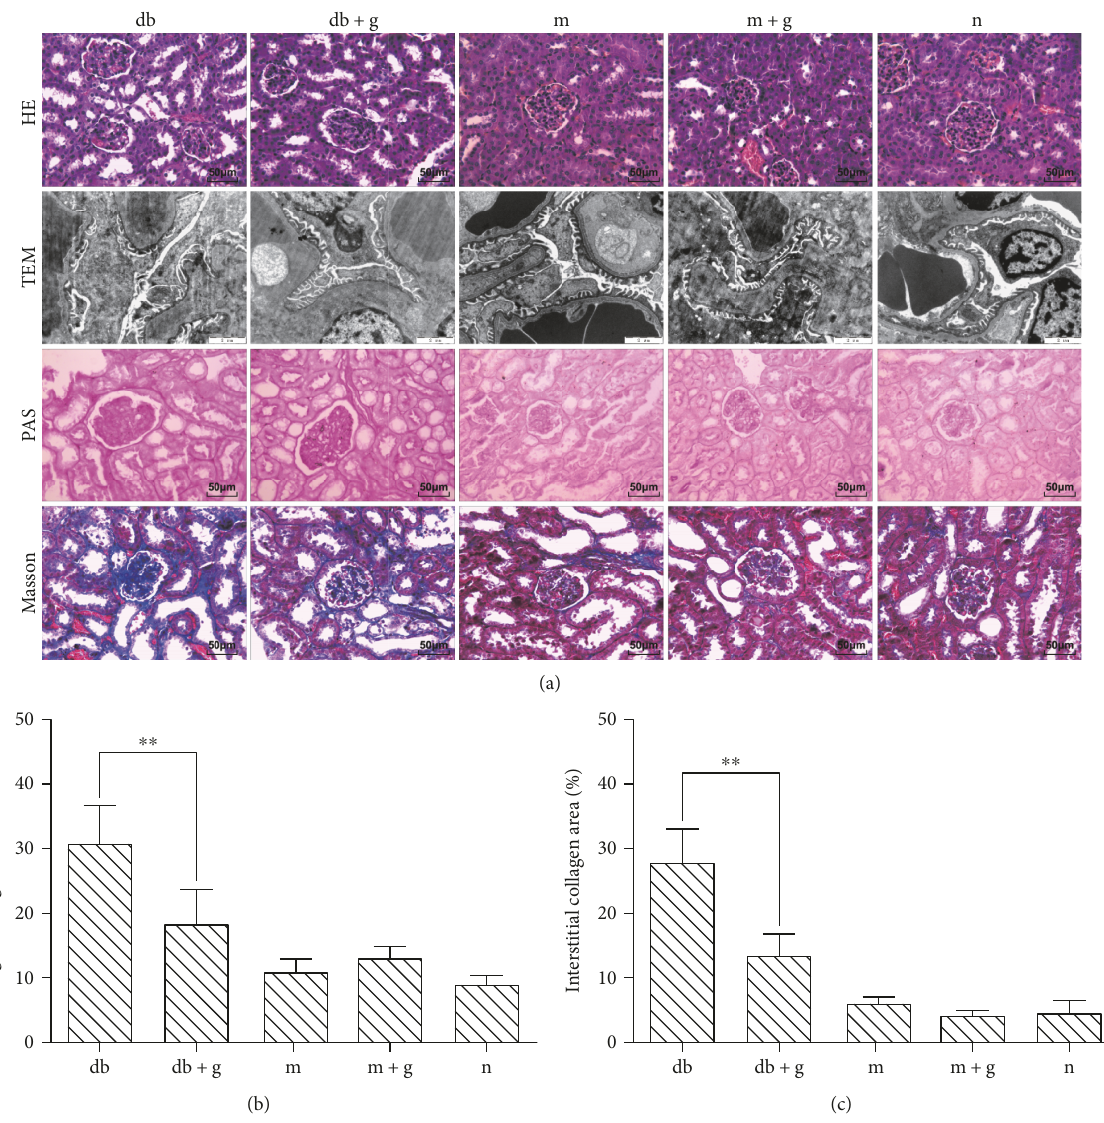
Figure 2: E ff ect of GA on kidney pathology in db/db mice. Representative sections obtained from the kidneys of mice (8 weeks old) in each group were stained with (a) HE × 400, electron microscopy (TEM) × 2000, and PAS × 400, Masson staining (blue) × 400. (b) Quantitative estimates of the mesangial fractional area (%). (c) Quantitative assessment of the interstitial collagen area (%). Values are shown as means ± SD. ∗∗ p < 0 01